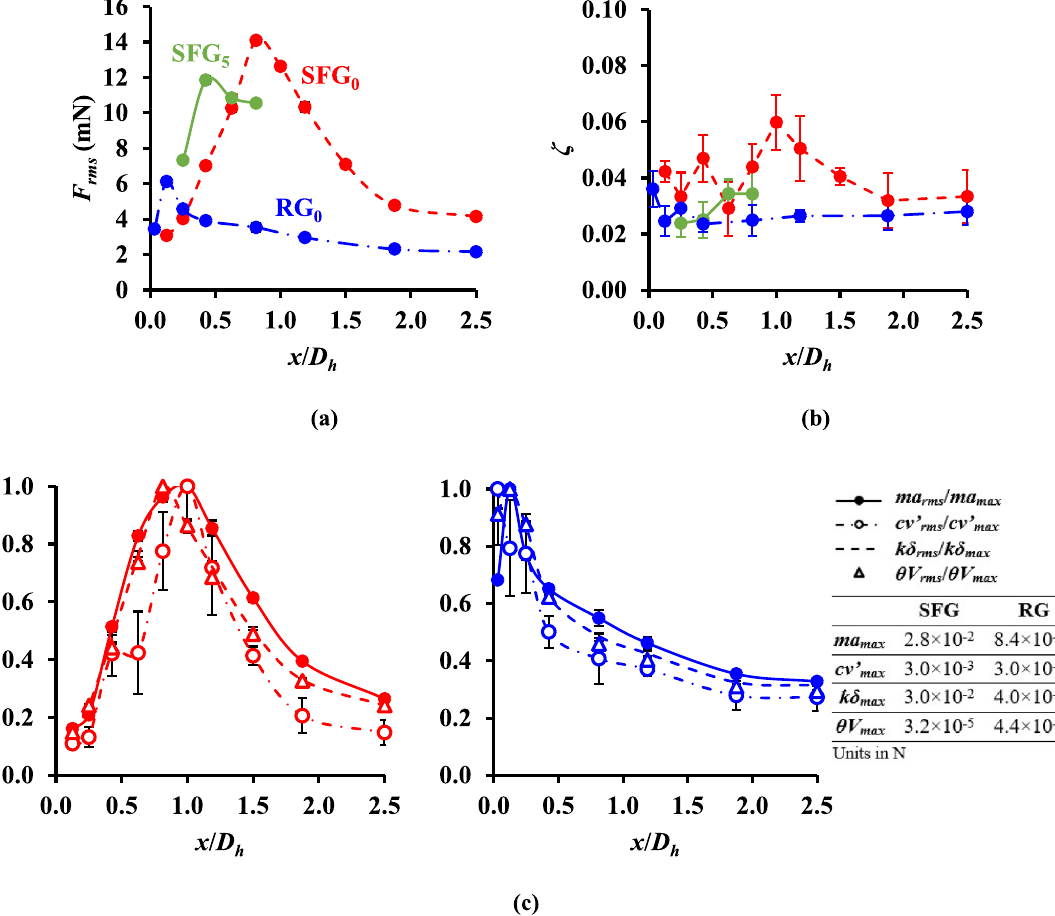
Figure 8. Grid-induced ( a ) RMS excitation force acting on the piezoelectric thin-film F rms and ( b ) damping ratio ζ against x / D h . ( c ) Downstream profile of the normalized acceleration ma rms / ma max , velocity cv ′ rms / cv ′ max , deflection kδ rms / kδ max and voltage θV rms / θV max terms along the centerline of SFG (red) and RG